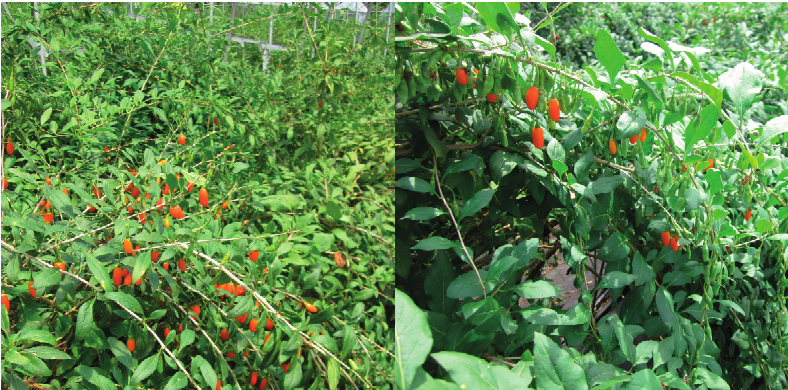
Figure 5. Chinese boxthorn ( Lycium chinense Mill) plant tissues were collected from farmer’s field in Cheongyang locality in